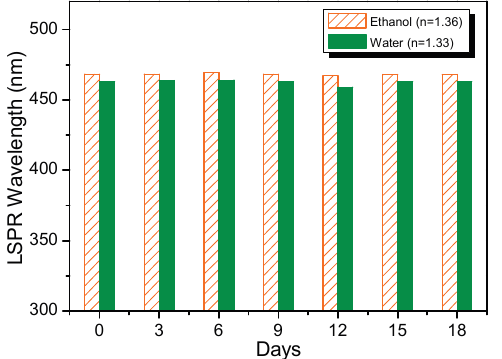
Figure 6. LSPR wavelength monitoring of the Ag NP-based sensor subjected in solutions with different refractive indices for a period of eighteen